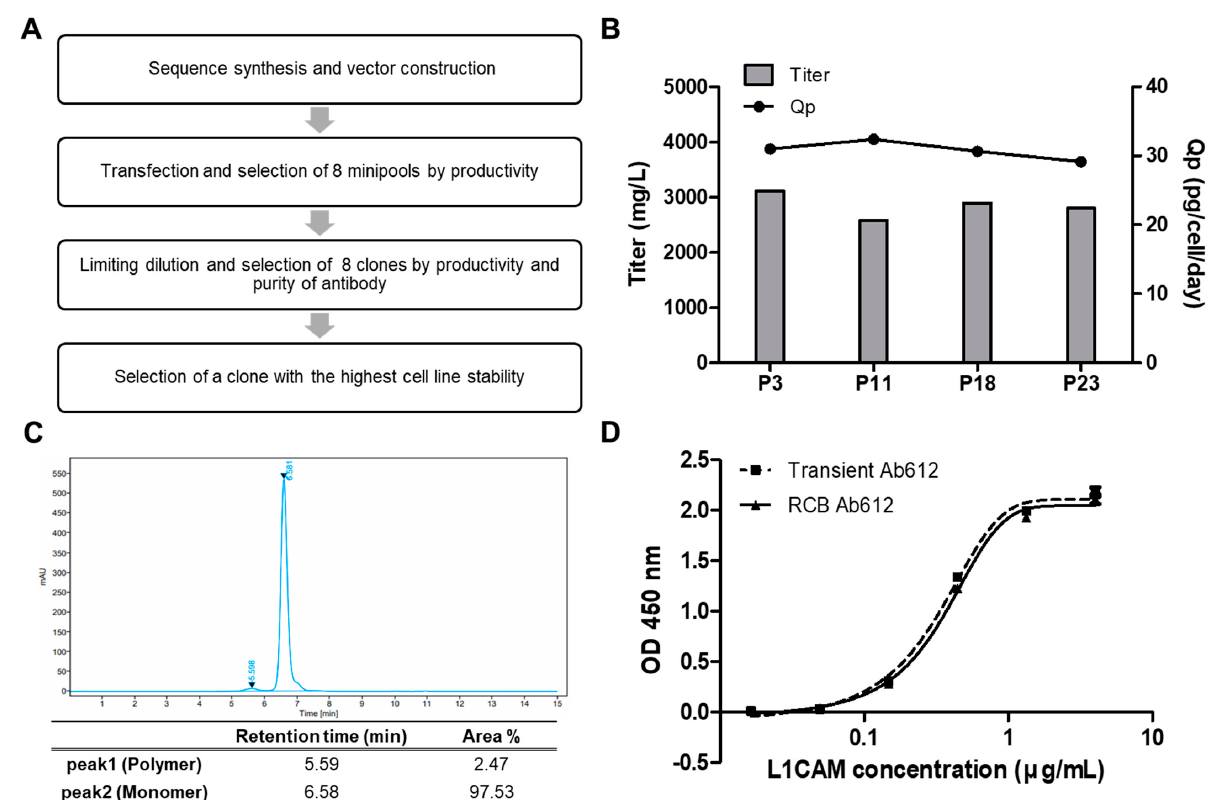
Figure 6. ( A ) Schematic diagram showing the generation of a research cell bank (RCB). ( B ) Ab612 titer was measured to assess the expression level, and Qp was calculated as PCD = (pg/cell/day) using PA-HPLC. ( C ) The purity of Ab612 produced from the RCB was analyzed by SEC-HPLC after purification. ( D ) Ag binding activity was determined by sandwich ELISA.